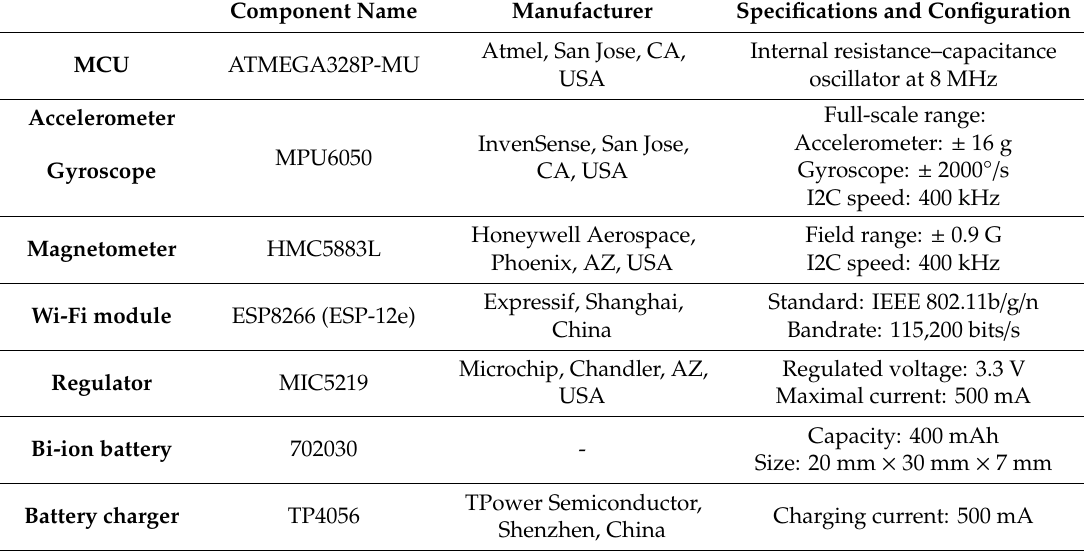
Table 1. Manufacturer, specifications, and configuration information of applied